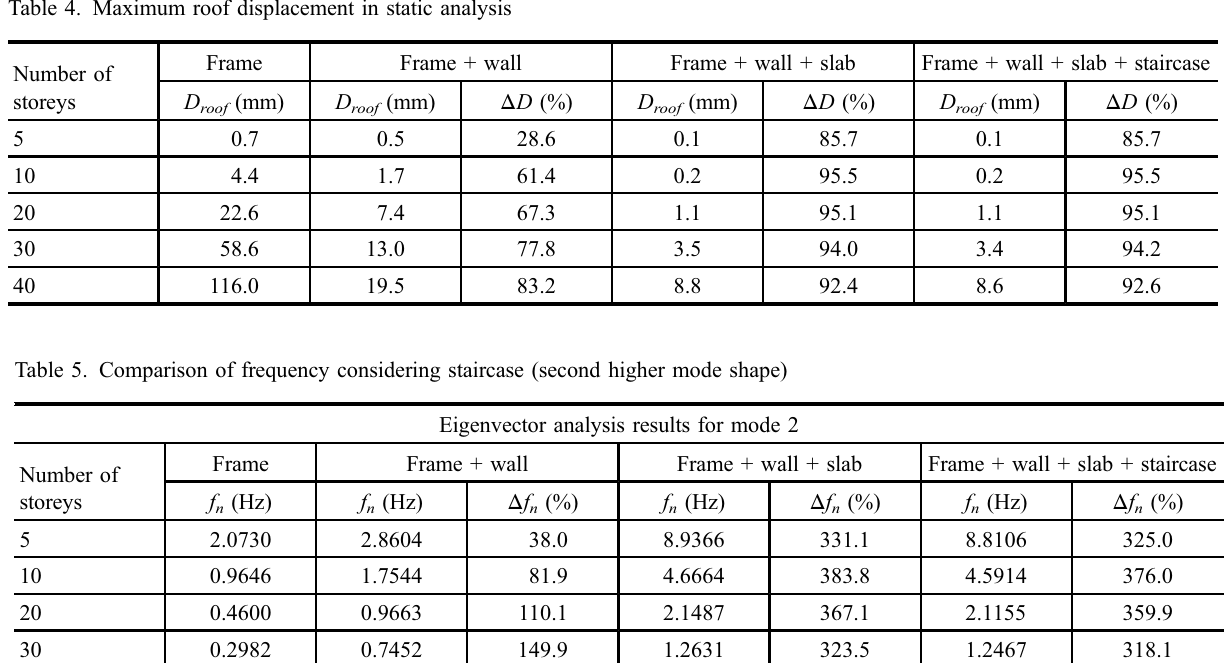
Table 4. Maximum roof displacement in static analysis Number of